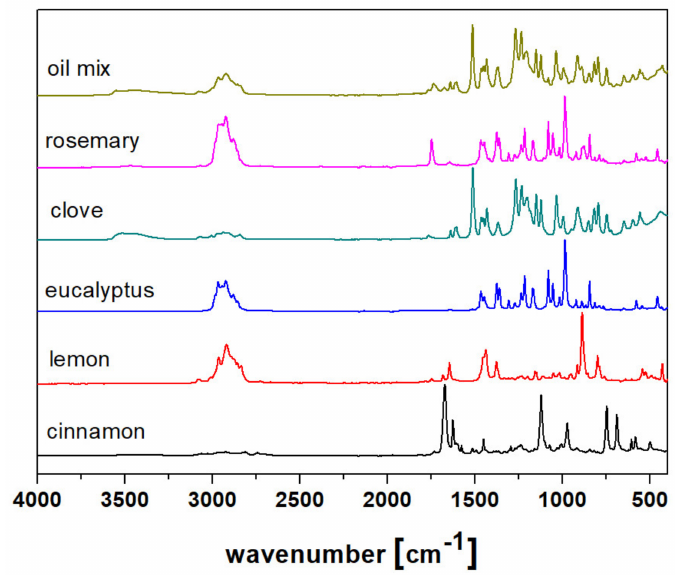
Figure 1. FTIR spectra of the examined